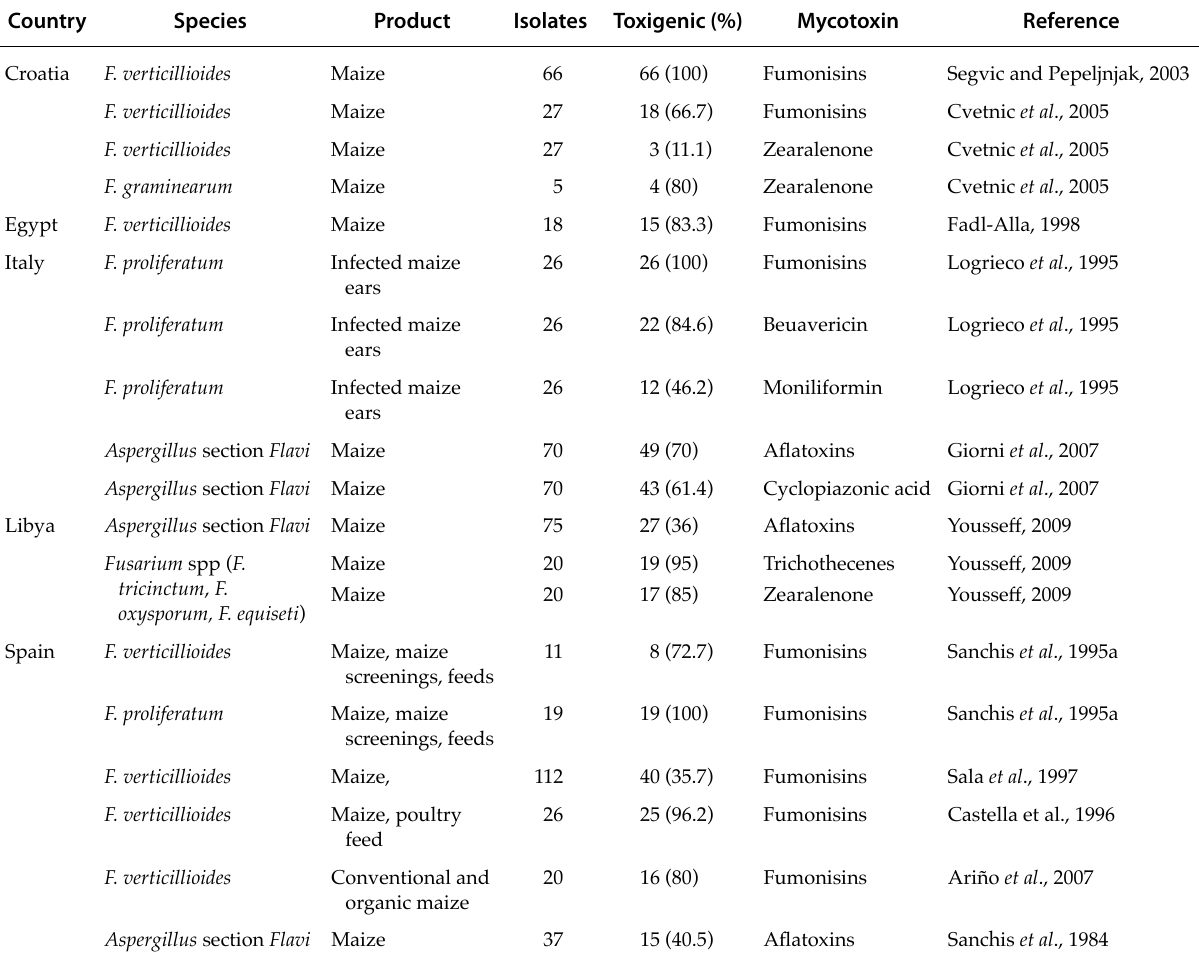
Table 1. Mycotoxin-producing ability of Fusarium and Aspergillus strains isolated from maize and milling fractions in Medi- terranean